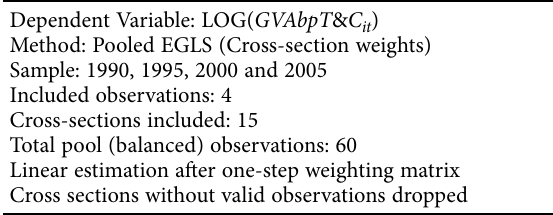
Table 8. Estimation equation for gross value added at basic prices across autonomous regions